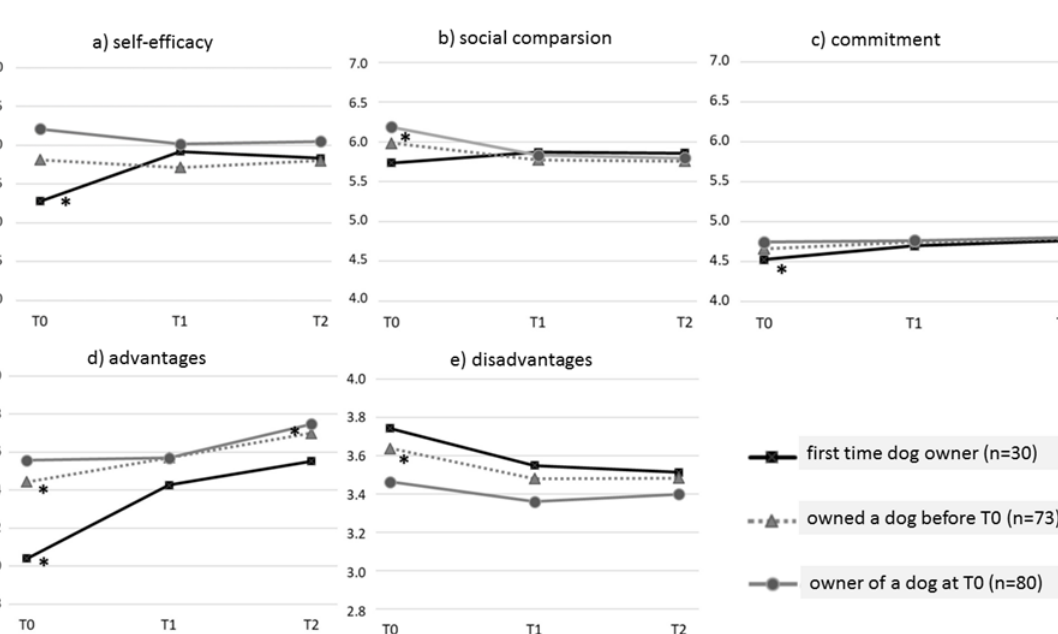
The abbreviation “Social comp.” refers to “Social comparison score”.